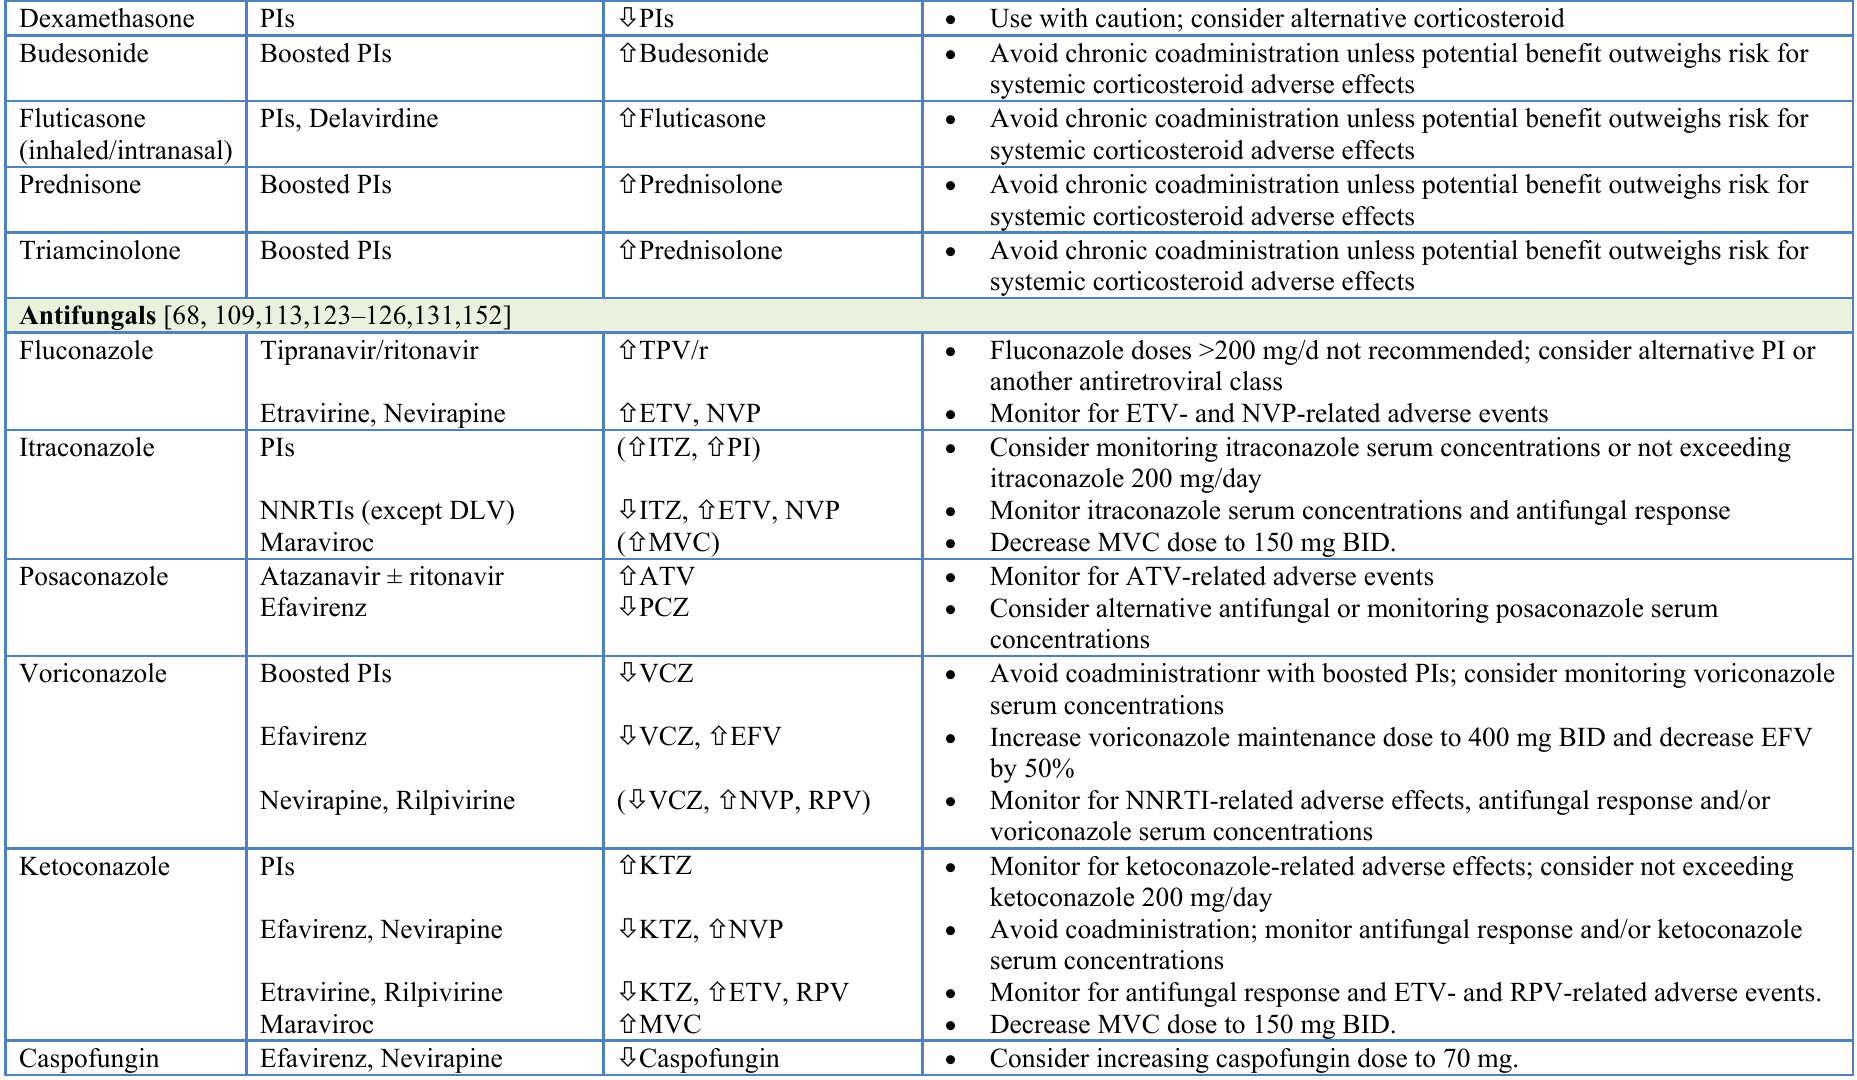
Table 2. Cont. • Use with caution; consider alternative corticosteroid • Avoid chronic coadministration unless potential benefit outweighs risk for systemic corticosteroid adverse effects